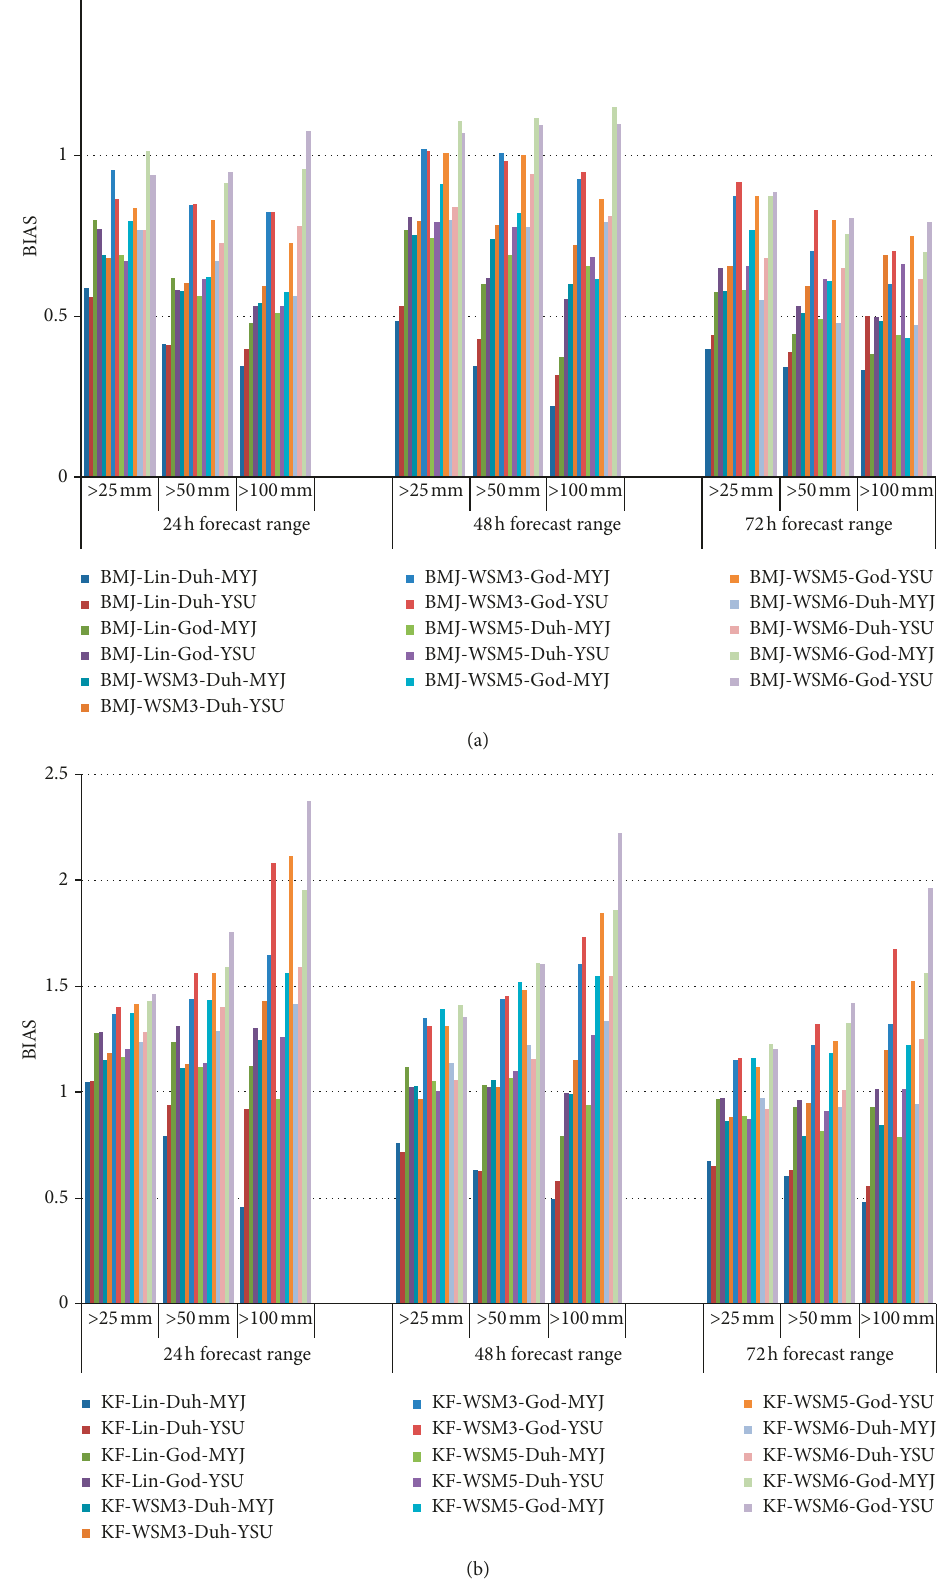
Figure 4: The BIAS score at 24h, 48h, and 72h for different thresholds (over 25mm, 50mm, and 100mm) for BMJ scheme combinations (a) and for KF scheme combinations (b). The number of samples is 8064 for an individual